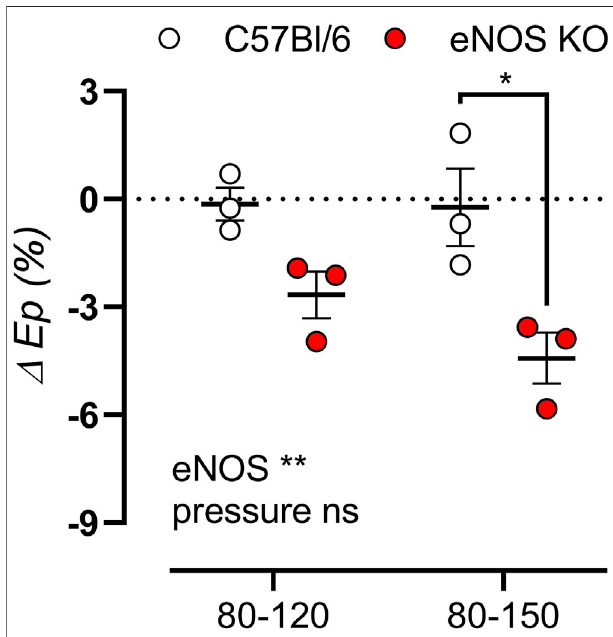
FIGURE 10 | Aortic stiffness in eNOS knockout mice decreases after cyclic stretch exposure. Aortic rings of eNOS knockout ( n = 3) and C57Bl/6 control ( n = 3) mice were exposed to 1 h cyclic stretch at calculated 80 – 120 mmHg or 80 – 150 mmHg pressures. The relative difference in E p after exposure was calculated. Presented results are the average of two aortic segments per mouse studied in parallel. Statistical analysis was preformedusingtwo-wayANOVA.Overallsigni fi cance(bottom)andpost-hoc signi fi cance (in graph) are listed. ns, p > 0.05, *, p < 0.05, **, p <